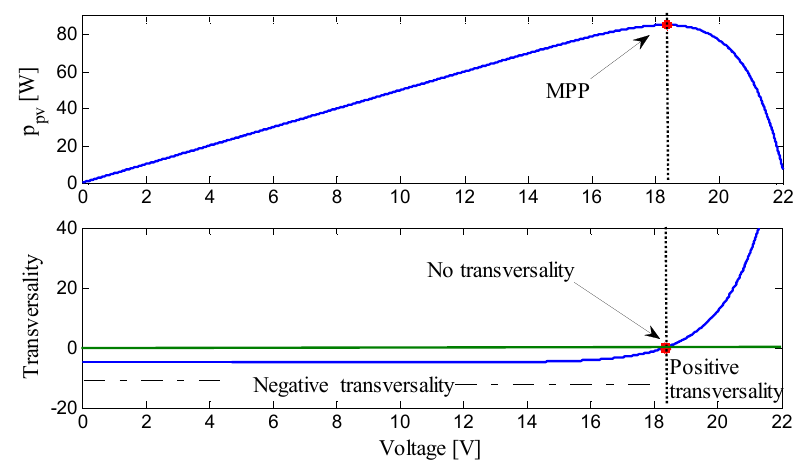
Figure 6. Simulation of the transversality condition.